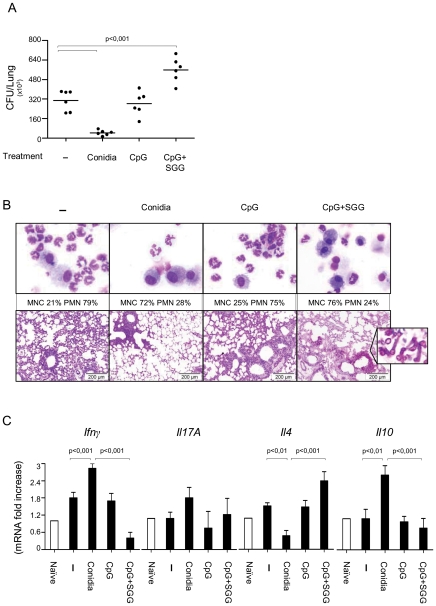
Vaccine potential of the urea soluble galactosaminogalactan (SGG) of A. fumigatus against invasive pulmonary aspergillosis.A, C57BL/6 mice were injected with 2×107
Aspergillus conidia 14 days or with CpG (10 nM) or CpG and SGG (5 µg) (CpG+SGG) 14, 7 and 3 days before the intranasal infection with 2 × 107 live resting conidia. Naïve are uninfected mice and – are infected, untreated mice. Fungal growth is expressed as CFUs per lung and statistical significance is indicated by a p value <0.001. B, Bronchoalveolar cells were obtained by lung lavage and lung histology (PAS-staining) was done 3 days after infection. Note that SGG failed to ameliorate inflammatory pathology and even favoured fungal growth (insert) in the absence of neutrophil recruitment. C, Cytokines were determined by RT-PCR in lung homogenates 3 days after the infection. Results pooled from 2 experiments (6 animals/group). Photographs were taken using a high-resolution Microscopy Color Camera AxioCam. Bars indicate SEM and statistical significance is indicated by p values.